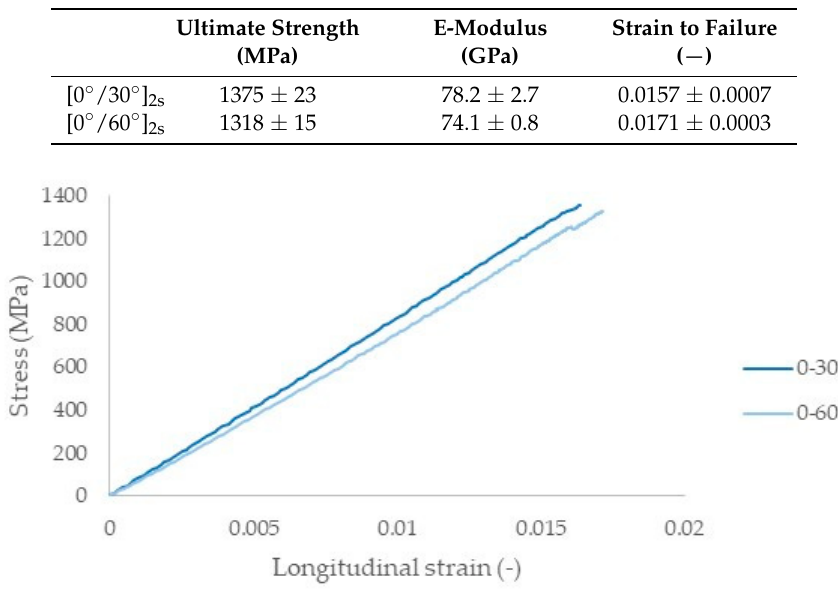
Table 2. Mechanical properties of the off-axis laminates acquired from the quasi-static tests.